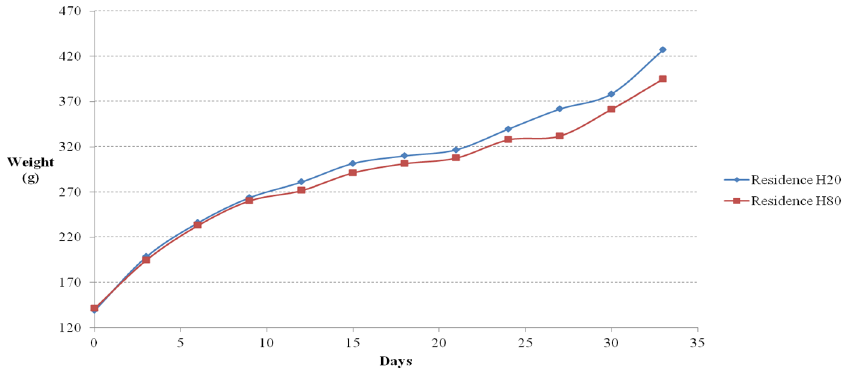
Figure 16. Weight change versus time curves (residence cages).